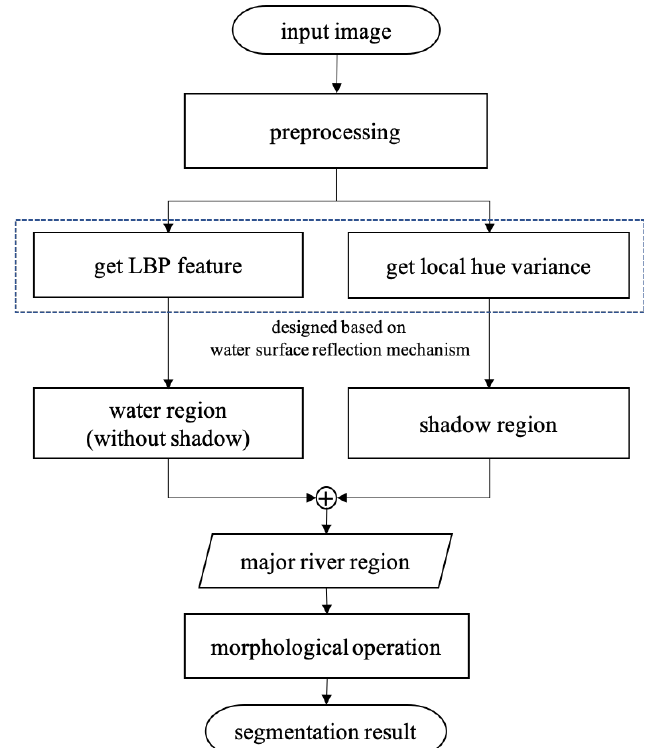
Figure 1. Flowchart of the proposed